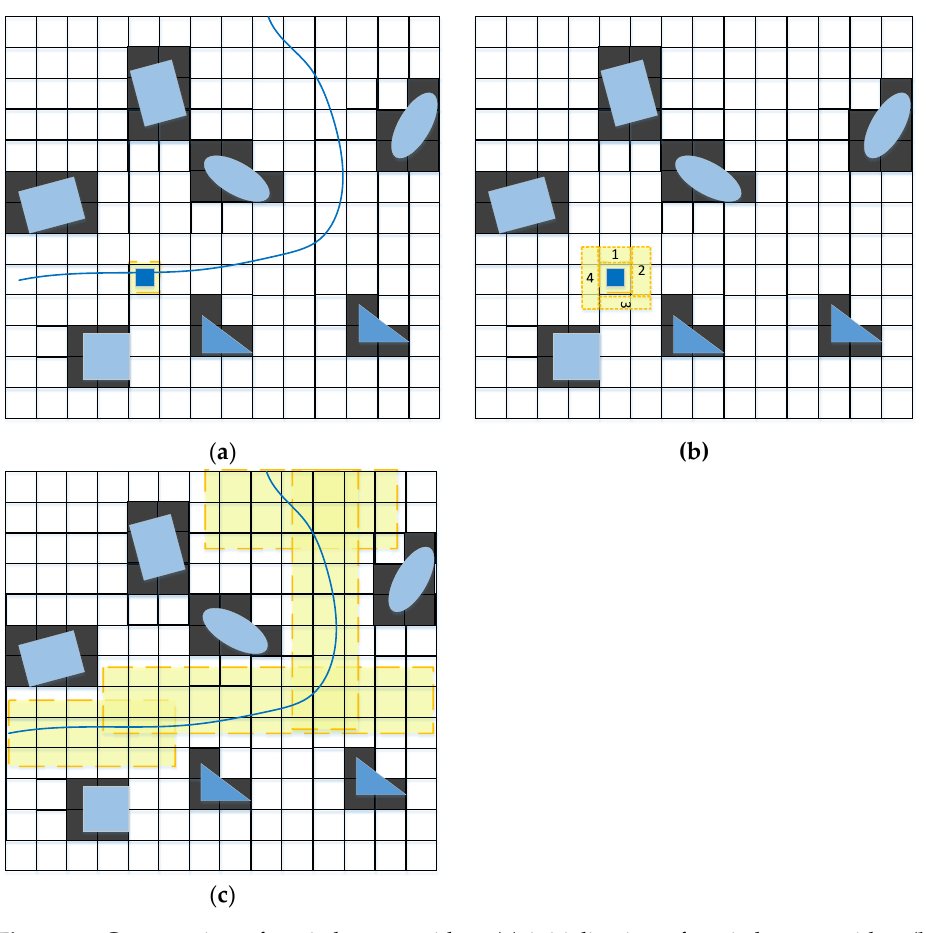
Figure 4. Construction of static-layer corridor: ( a ) initialization of static-layer corridor, ( b ) the expansion process of a static-layer corridor, ( c ) complete static-layer corridors.